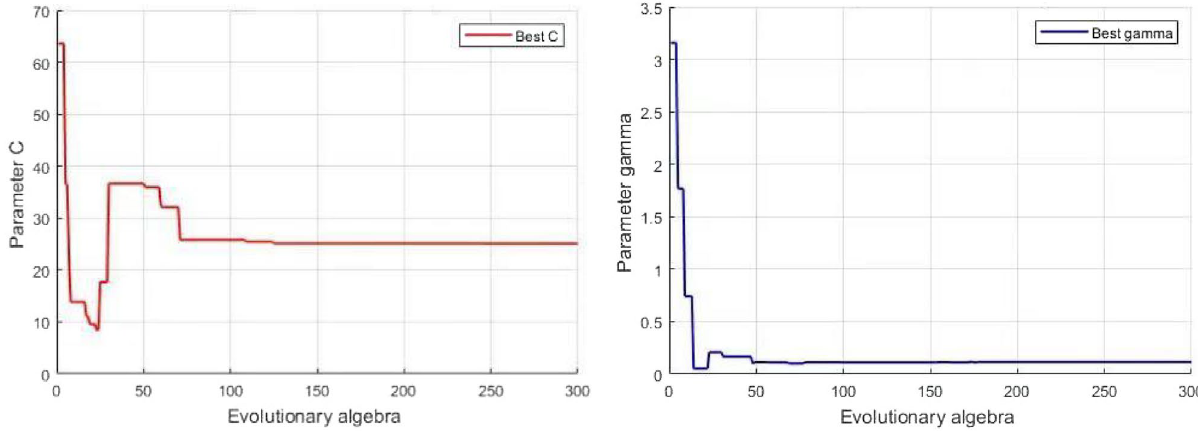
Figure 5. Optimization curve for parameter C (left) and Optimization curve for parameter γ